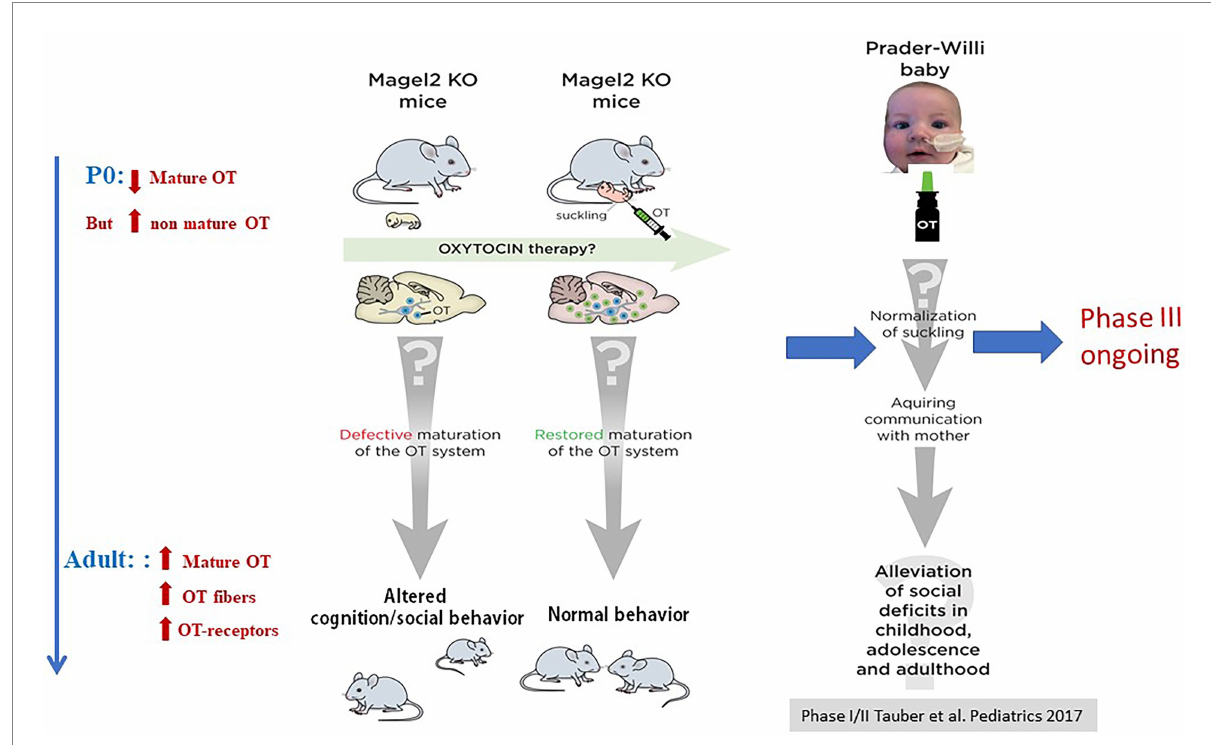
FIGURE 4 Alterations of OT-system and OT-rescue in Magel2 KO mice and effects of OT intranasal administration in babies with PWS. Adapted from Muscatelli et al.